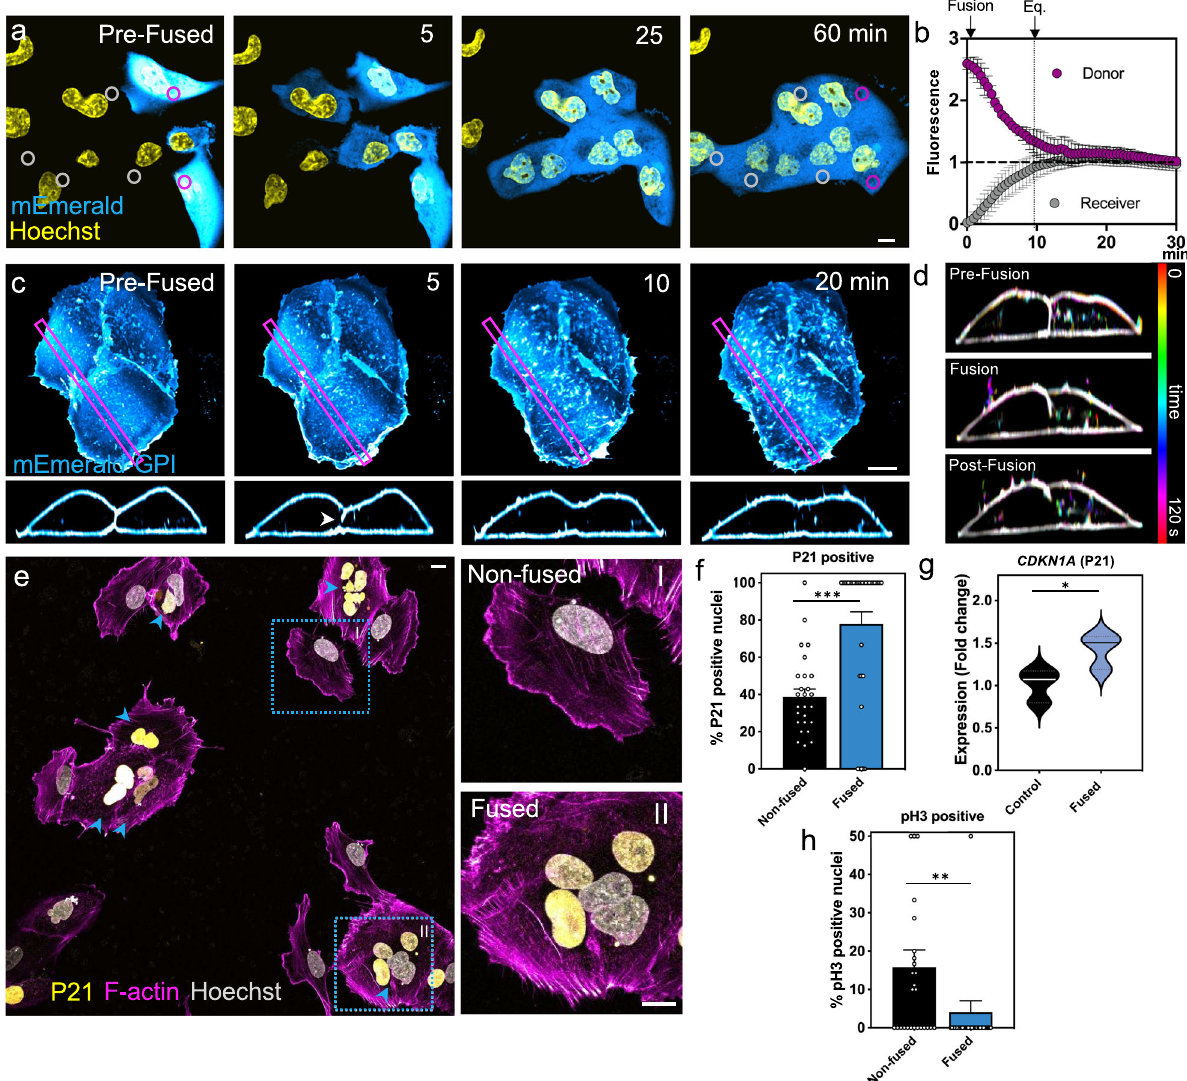
Fig. 1 Changes in fundamental cellular features upon cell fusion lead to cell cycle exit. a Cells expressing VSV-G alone (Receiver cells) or co-expressing VSV-G and a cytoplasmic marker (Donor cells, cytoplasmic mEmerald) were mixed and fused by a brief wash with Fusion Buffer and then were imaged by confocal microscopy. Cytoplasmic mixing was measured as fl uorescence intensity changes in ROIs of Donor (magenta ROI) and Receiver (gray ROI) cells overtime upon fusion (see also Supplementary Movie 1). b Equilibration (Eq) of cytoplasmic mEmerald fl uorescence intensity is marked with a vertical line. Error bars represent the standard error of the mean (SEM), n = 4 replicates for Receiver cells (gray dots) and n = 2 for Donor cells (magenta dots). c , d Cells expressing VSV-G and a plasma membrane marker (mEmerald-GPI) were induced to fuse. c Fusion pore formation (insets, white arrow head) and changes in the plasma membrane were assessed by lattice light-sheet microscopy. d Temporal color-coded images were generated by compressing 2 min from time points before (pre-fusion), during (Fusion), and after (post-fusion) cell fusion (see also Supplementary Movie 2). Images in c and d are representative of four experiments. e Representative confocal images of immuno fl uorescence staining of P21-positive nuclei in non-fused and fused cells (insets I and II, respectively) (arrow heads point to positive P21 nuclei in fused cells). f The percentage of P21-positive nuclei in non-fused (black bar) and fused cells (blue bar) quanti fi ed in cells imaged 24 h after washing with Fusion Buffer are graphed. Error bars represent the SEM, n = 27 and n = 34 cells examined over three independent experiments for non-fused and fused cells, respectively, *** p < 0.0001. g Violin plots depict the fold change in CDKN1A transcript (which codes for P21) expression quanti fi ed by qRT-PCR after 24 h in unwashed control (black) and fused (blue) cells. n = 3 independent experiments, * p = 0.0412. h 24 h after washing with Fusion Buffer, cells were stained for the protein pH3, a positive indicator of mitosis, and the percentage of pH3-positive nuclei in non-fused (black bar) and fused (blue bar) cells. Error bars represent the SEM, n = 27 and n = 37 cells examined over three independent experiments for non-fused and fused cells, respectively. ** p = 0.0279. Statistical signi fi cance calculations were performed using a two-tailed unpaired Student ’ s t test. Scale bar size = 10 μ actin dynamics after fusion using a stable U2OS line expressing Nuclei tracking analyses demonstrated that nuclei from fusing an F-actin marker (lifeact-EGFP) and observed that actin cells start to move toward the center of the newly formed structures correlated with changes in PM remodeling (Supple- syncytium within 10 min, and stably converge within 60 min mentary Fig. 2 and Supplementary Movie 4). (Supplementary Fig. 1e, f and Supplementary Movie 5).